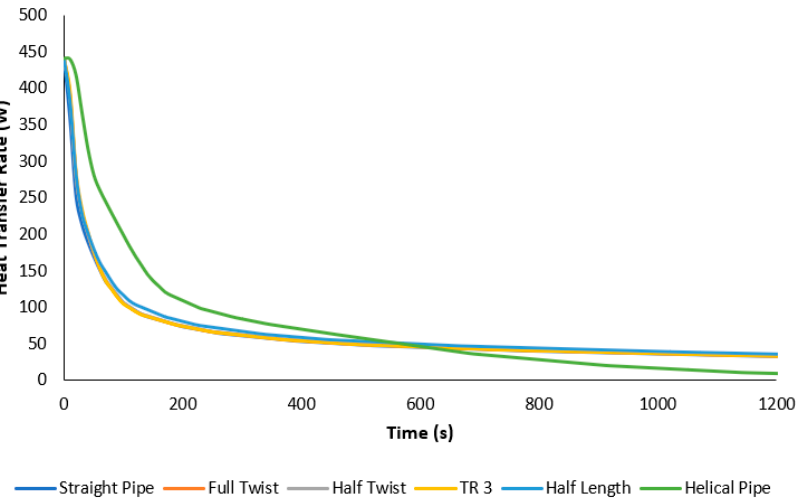
Figure 7. Heat transfer rate of the various configurations (note: the full twist, half twist and TR3 lines approximately overlap and some of the lines are not visible).